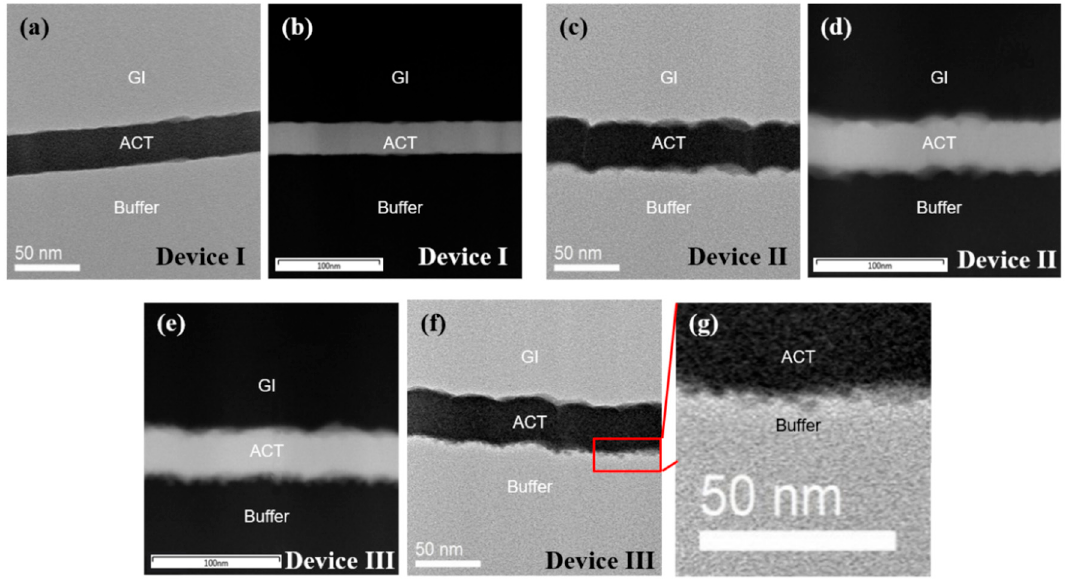
Figure 4. High-resolution TEM (HR-TEM) images of the gate insulator (GI) (SiO 2 )/active (IGZO)/buffer (SiO 2 ) interfaces for devices ( a ) I, ( c ) II and ( f ) III, respectively. Annular dark-field (ADF) images in a scanning TEM (STEM) for devices ( b ) I, ( d ) II and ( e ) III, respectively. (g) Enlarged interface of device III.